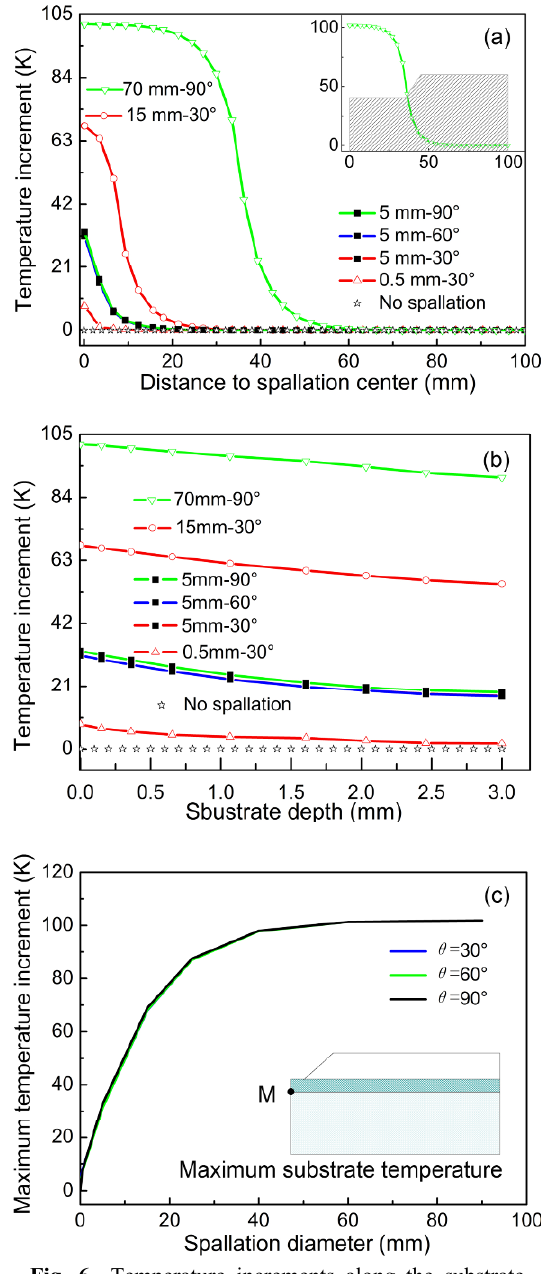
Fig. 6 Temperature increments along the substrate surface (a) and its in-depth directions (b) with different spallation dimensions. (c) is the maximum temperature increment in substrate surface (corresponding to the spallation area center, point M) as a function of the tilt angle and the spallation